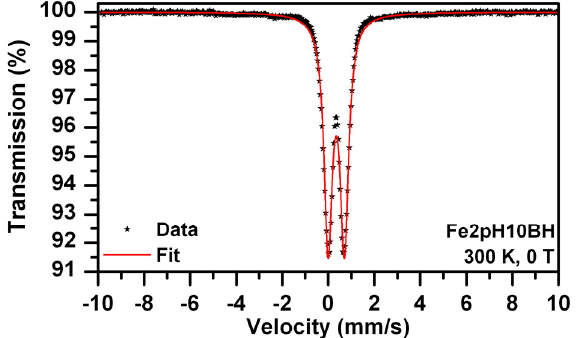
Figure 2. Mössbauer spectrum of Fe2pH10BH recorded at room